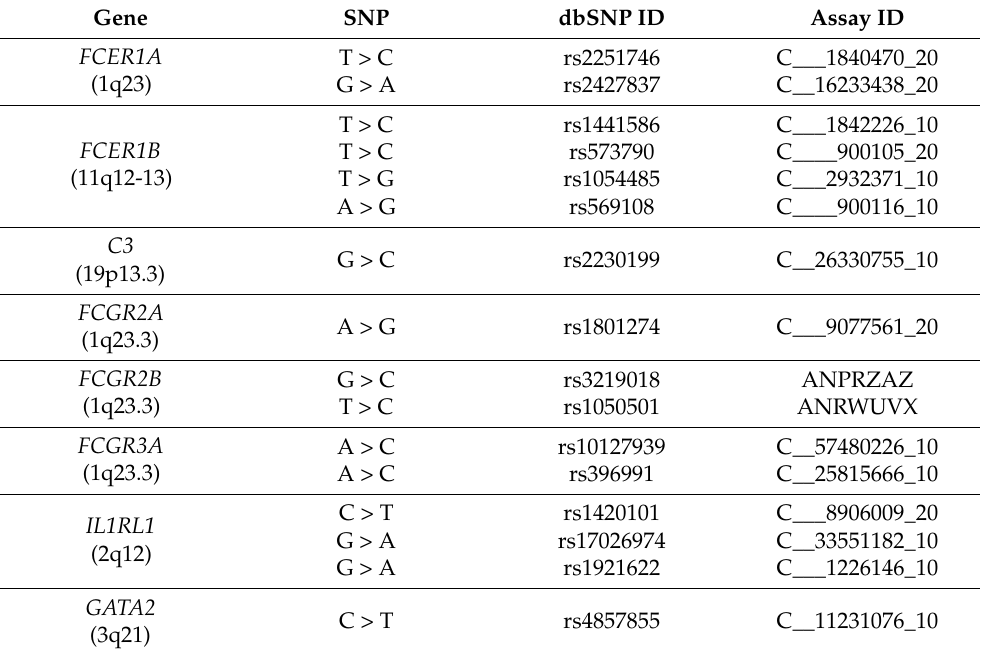
Table 4. Gene polymorphisms and TaqMan